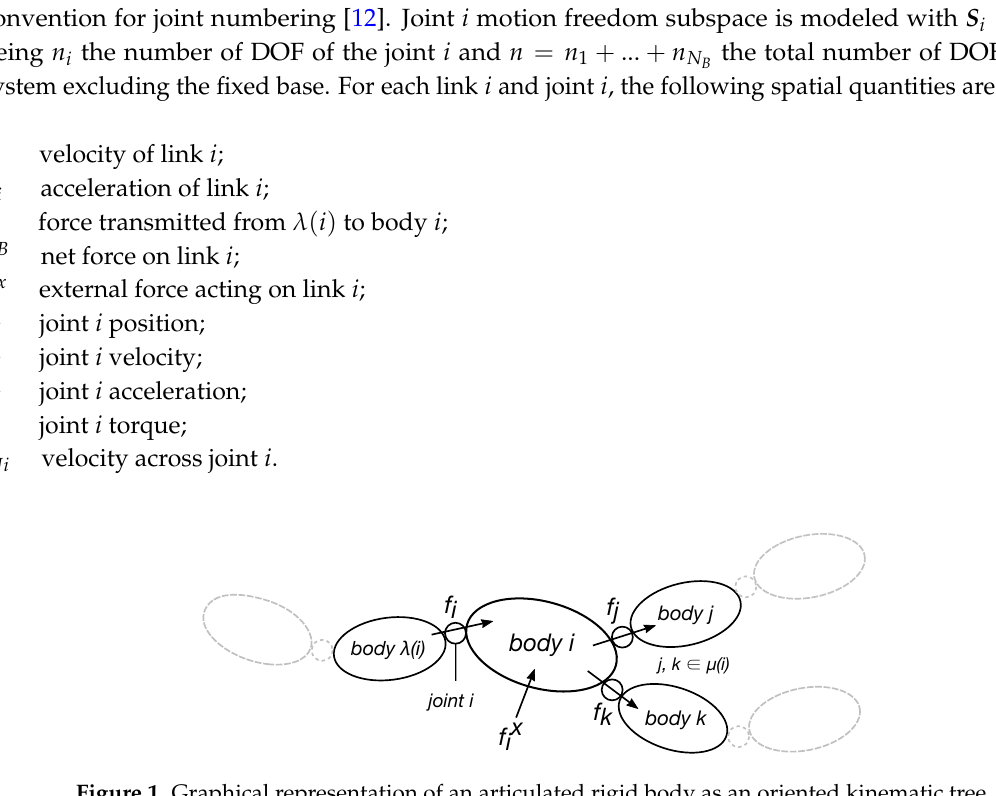
Figure 1. Graphical representation of an articulated rigid body as an oriented kinematic